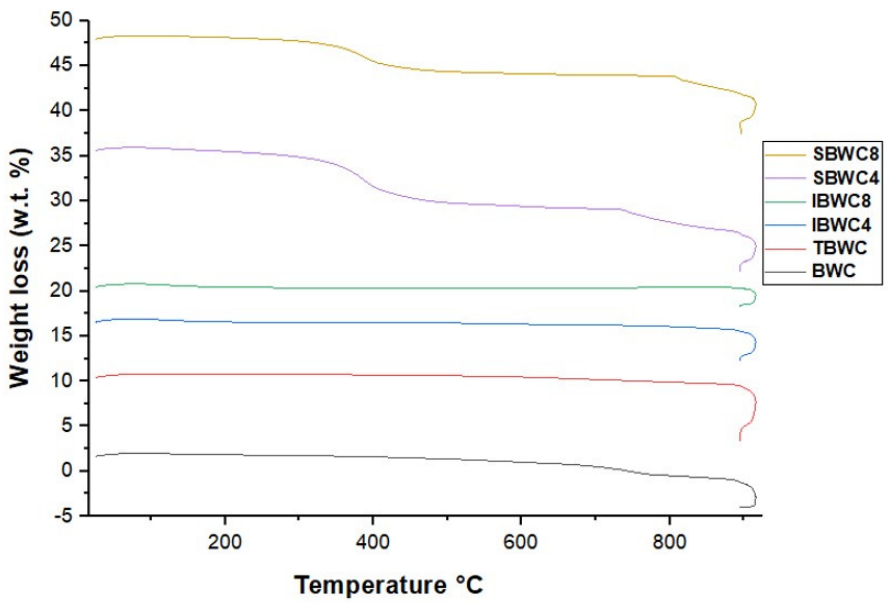
Figure 4. Thermal gravimetry decomposition of prepared catalyst from biochar woodchip.